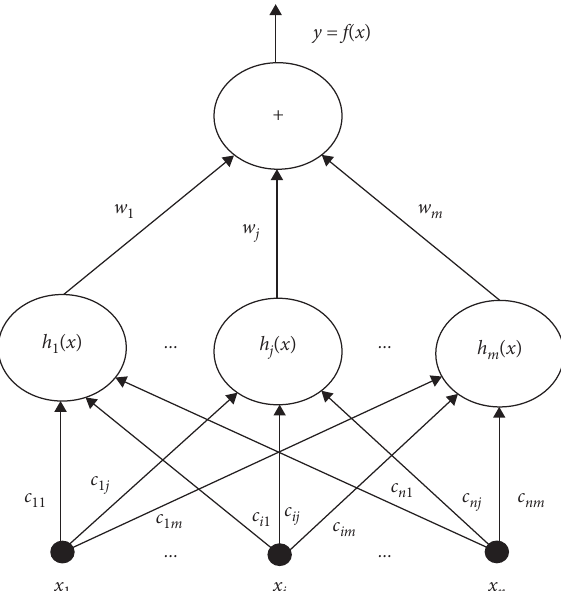
Figure 5: Radial basis neural network